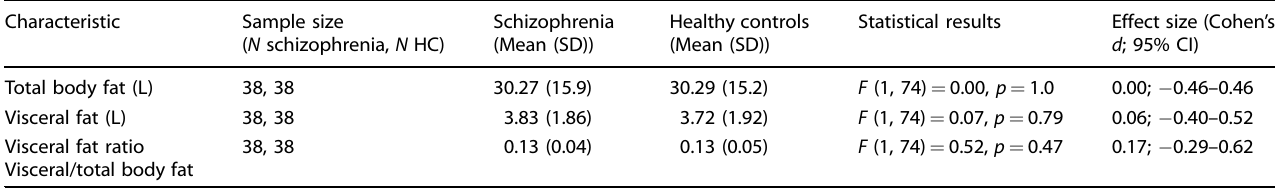
Table 1. MRI-derived measurements in participants with schizophrenia and matched healthy